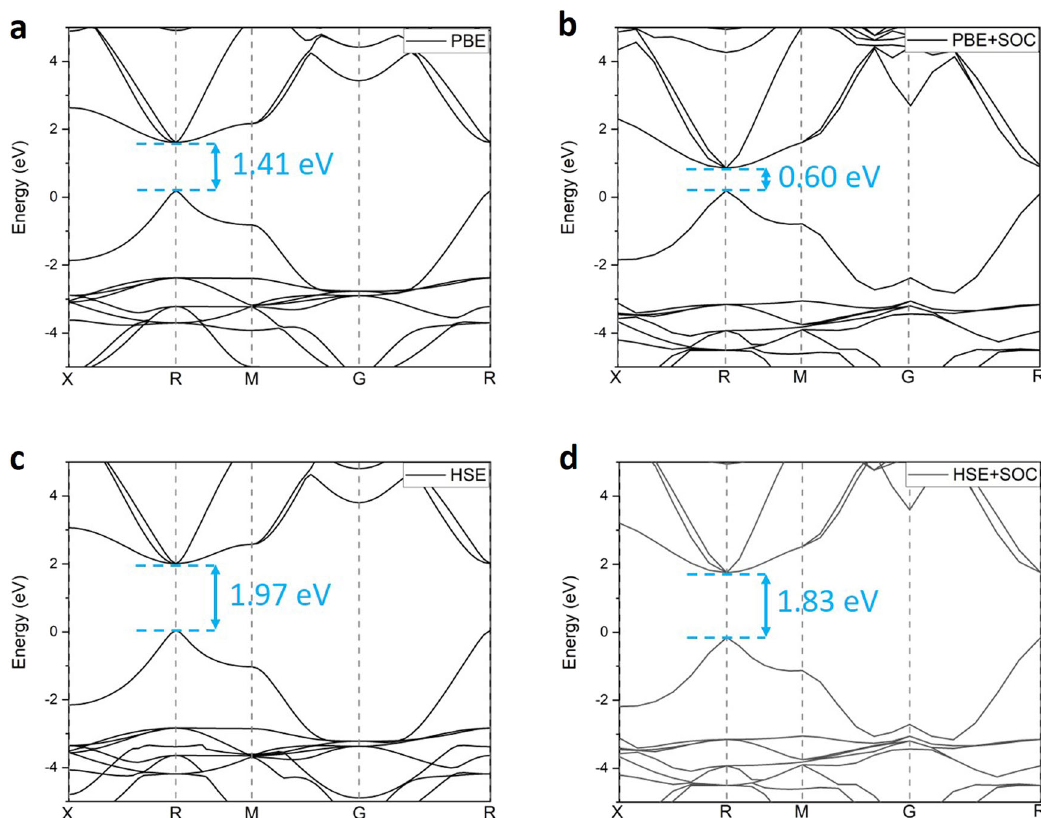
Fig. 1 The band structures of bulk CsSnBr 3 . Calculated with the a PBE, achieving a bandgap of 1.41 eV, b PBE + SOC (0.60 eV), c HSE (1.97 eV), and d HSE + SOC (1.83